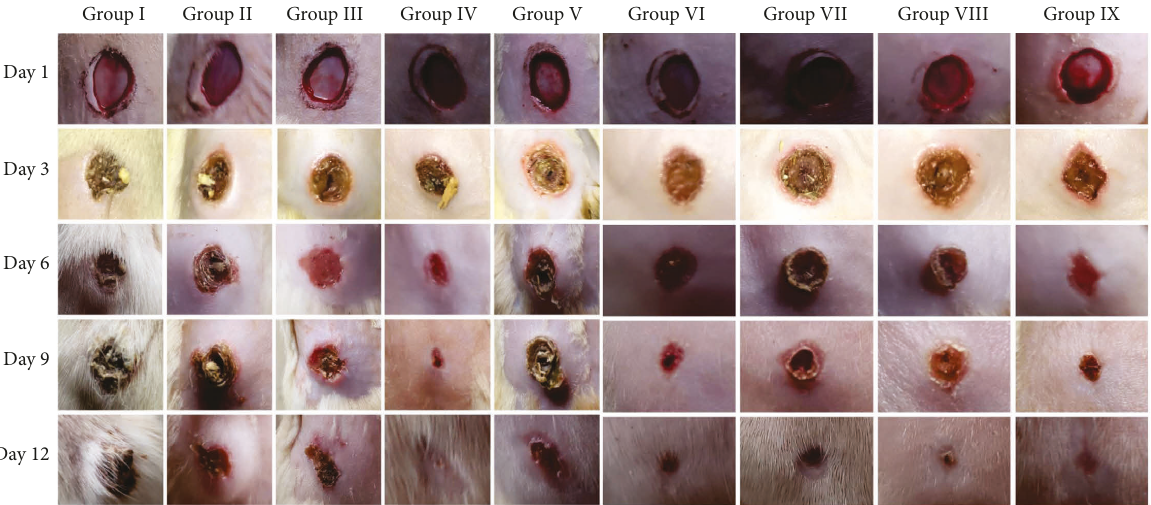
Figure 3: Image of wound contraction in experimental groups for days 1, 3, 6, 9, and